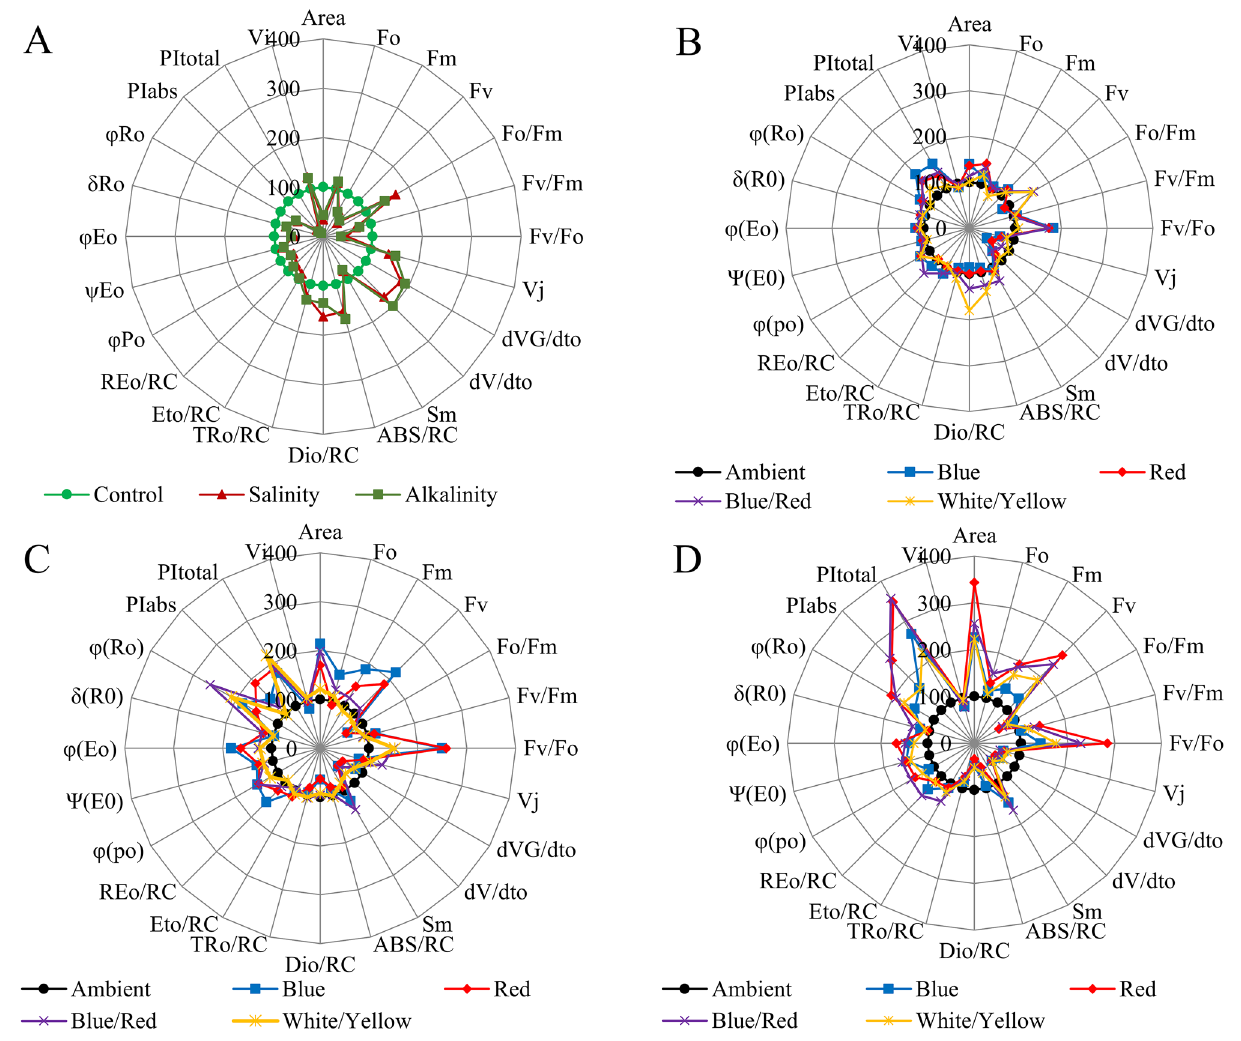
Figure 6. JIP-test parameters normalized on radar plots. ( A ) The effect of ambient light conditions on non- stressed plants; ( B ) the effect of salt stress at different light conditions; ( C ) the effect of alkalinity stress at different light conditions; ( D ) the effects of salinity and alkaline stress at ambient light conditions. Biophysical parameters were determined with "PEA Plus" software version 1.12 (http:// www. hansa tech- instr uments. com). The graphs were drawn using Microsoft Excel version 2016 (https:// www. micro soft. com).